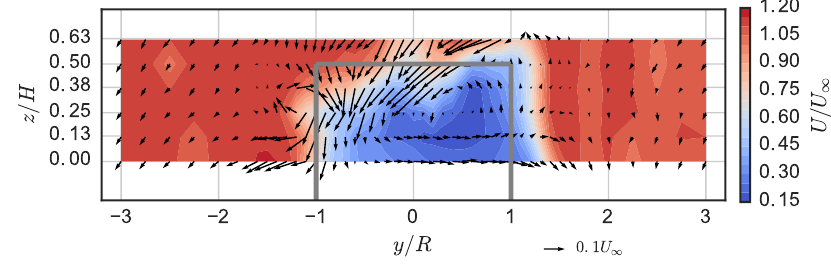
Figure 10. Mean velocity field at x / D = 1, λ = 1.9, and Re D = 1.0 × 10 6 .